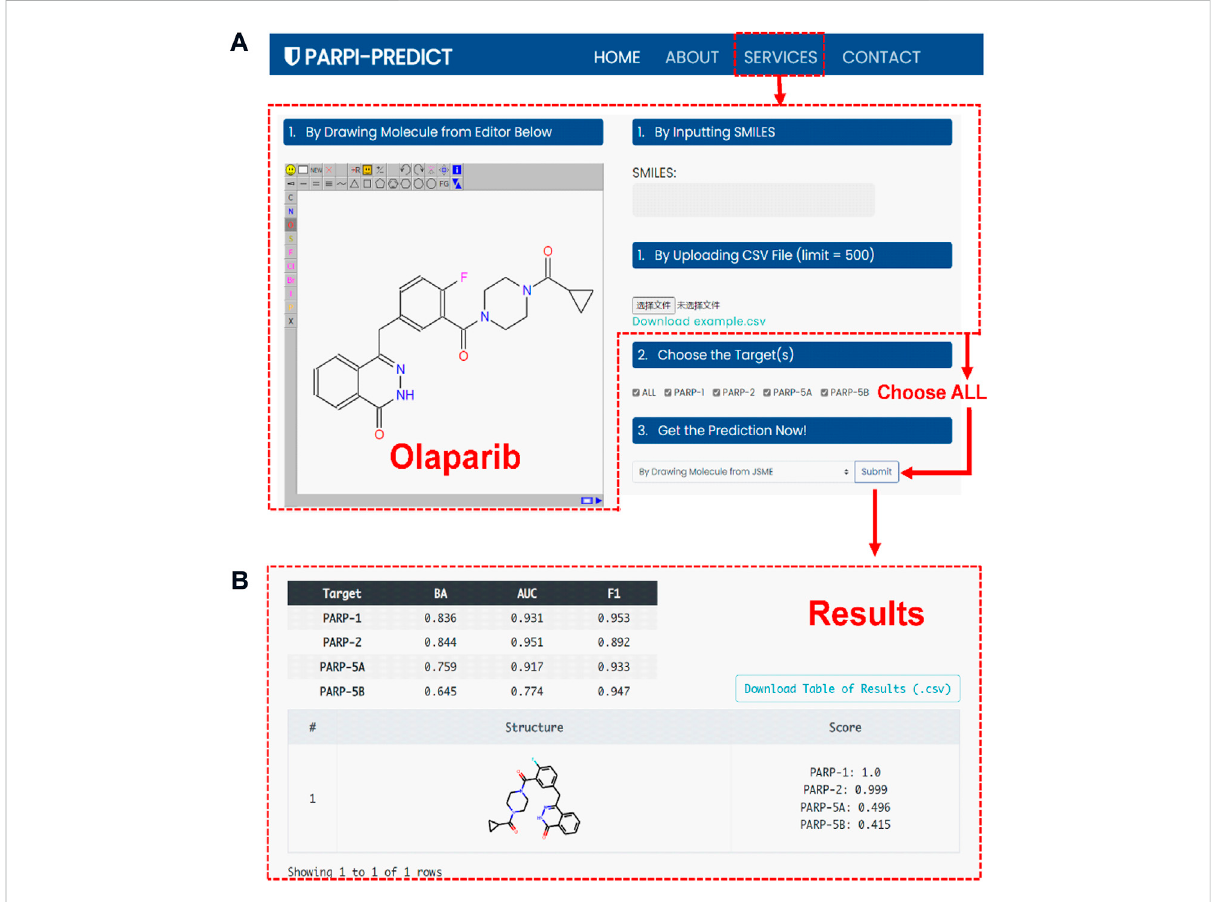
FIGURE 10 (A) The service interface of the PARPi-Predict. (B) The prediction results of